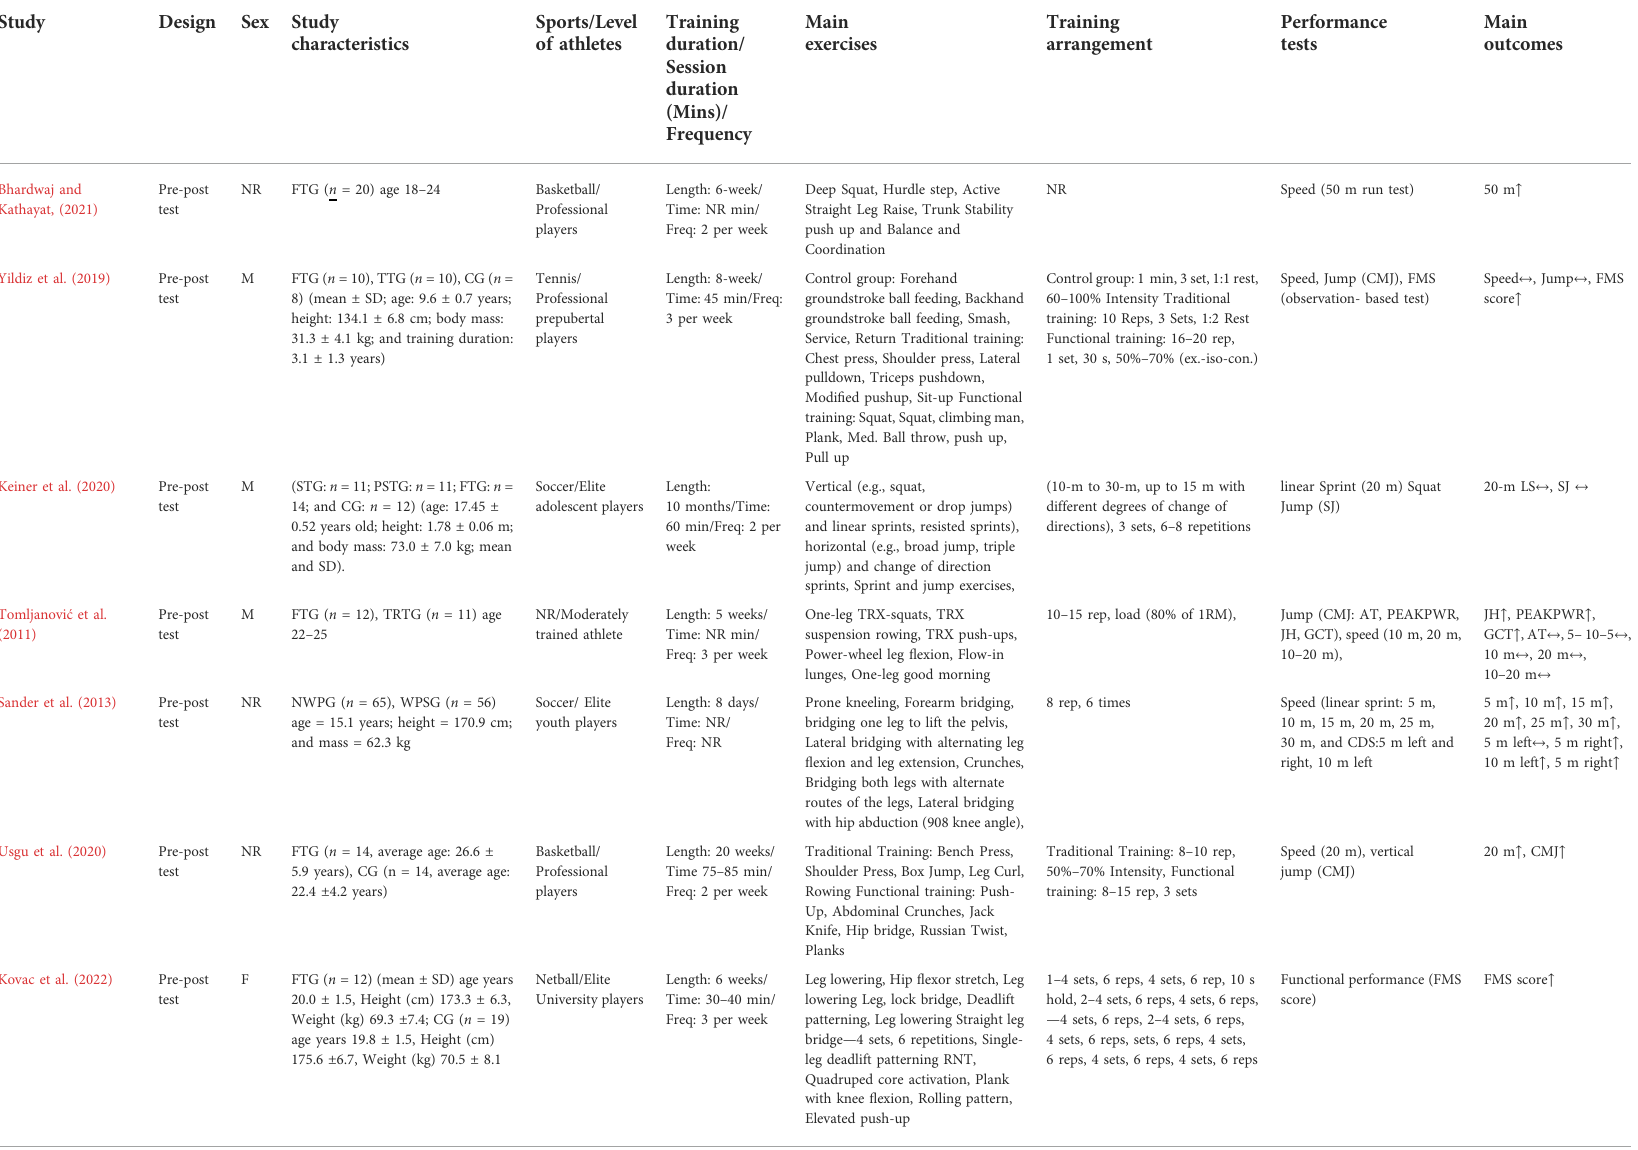
TABLE 2 Summary of details regarding each included